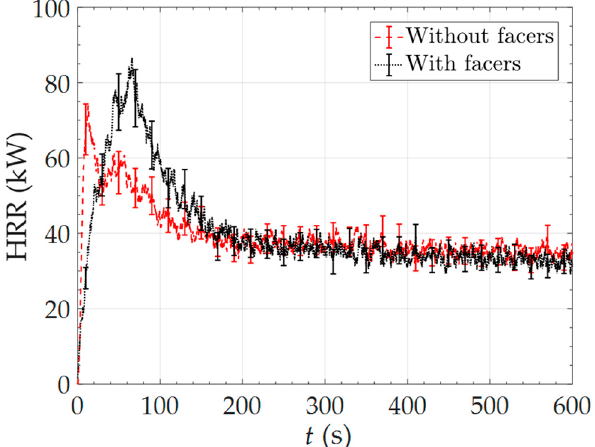
Figure 7. Heat release rates measured in the vertical corner flame spread experiments on the Tuff-R insulation panels with and without facers.